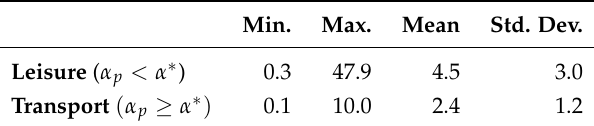
Table 1. Distance Statistics (km).